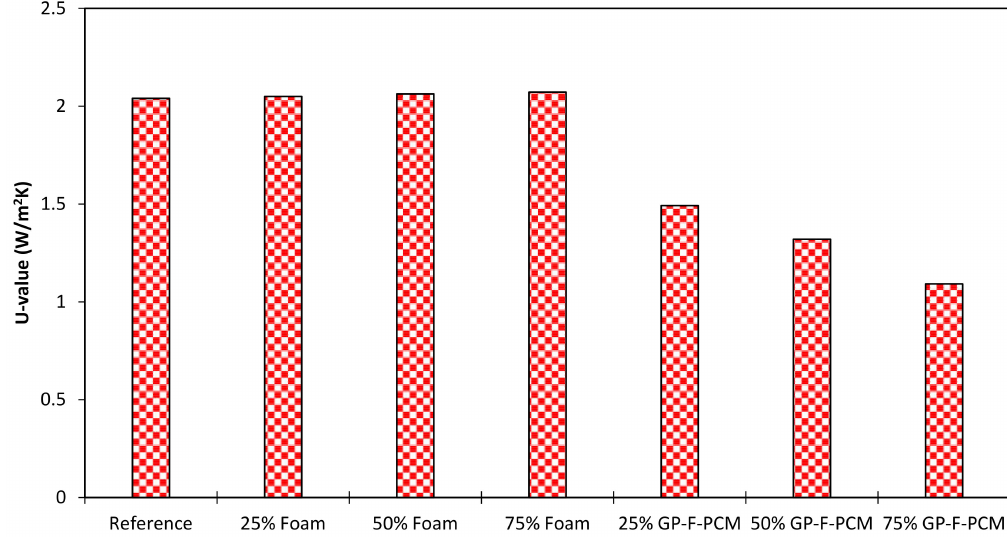
Figure 9. U-value of GPC blocks measured experimentally.